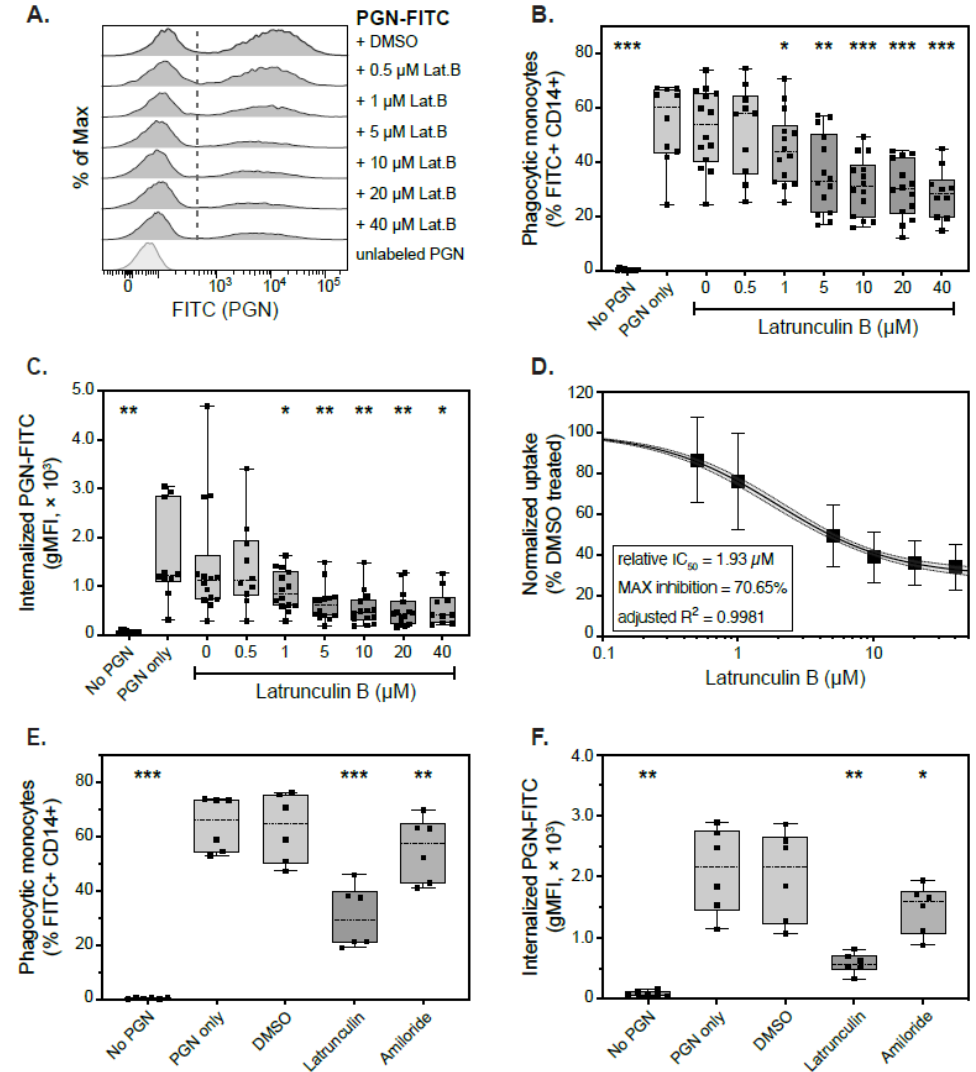
Figure 3. Monocyte uptake of PGN preferentially, but not exclusively, employs actin-dependent pathways. ( A ) Representative histogram overlay of a median responsive individual depicting titration of the latrunculin B inhibition of PGN uptake. For comparison, the internalization of unlabeled PGN in DMSO-treated monocytes is shown in the bottom panel, while the threshold used to assess phagocytic cells is depicted graphically as a segmented line. ( B , C ) Graphical representation of PGN uptake sensitivity to latrunculin B in 14 independent individuals, depicted as either phagocytic monocytes ( B ) or geometric mean of fluorescence intensity of internalized PGN-FITC particles ( C ). ( D ) Mathematical modelling of latrunculin B inhibition of PGN-FITC uptake. After pairwise normalization of PGN uptake, a four-parameter logistic curve (continuous line) was fitted by least square regression, and the relative IC 50 and predicted maximum inhibition with latrunculin B were extracted from the model and shown in the inset. Dotted lines and shaded area depict the 95% confidence interval of the polynomial fit. ( E , F ) Pairwise comparison of PGN uptake sensitivity to latrunculin B (20 µ M) and the macropinocytosis inhibitor amiloride (1 mM) in 6 independent donors, depicted as either phagocytic monocytes ( E ) or geometric mean fluorescence intensity of internalized PGN-FITC particles ( F ). Statistically significant differences compared to PGN uptake in the absence of the inhibitor in panels ( B , C , E , F ) are depicted conventionally (* p < 0.05, ** p < 0.01, *** p <